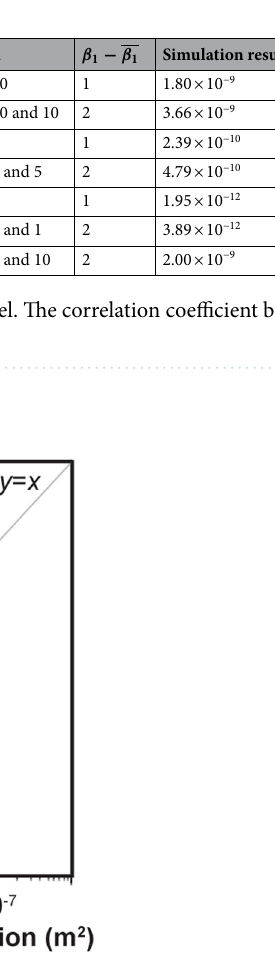
Figure 6. Estimation of permeability by persistent homology (PH) analysis for orthogonal fracture networks (blue) and random fracture networks (orange). The calculated permeability is listed in Table 1.